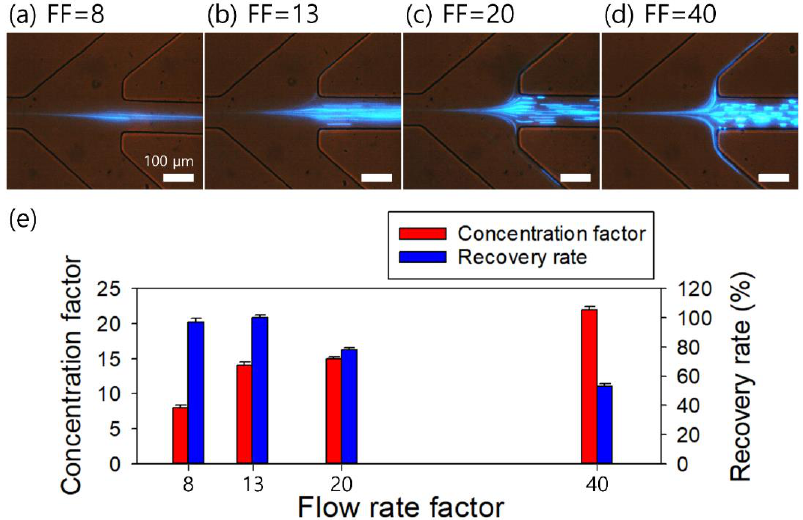
Figure 3. Evaluation of the effect of the flow rate factors (FF) determined by the suction flow rate from outlet A on the flow characteristics of the 2- μm fluorescent particles in 2000 -ppm PEO solution. ( a ) FF = 8, ( b ) FF = 13, ( c ) FF = 20, ( d ) FF = 40. ( e ) Recovery rate and concentration factor at various FF values. The standard deviations depict the measured values from five different experiments ( n = 5).